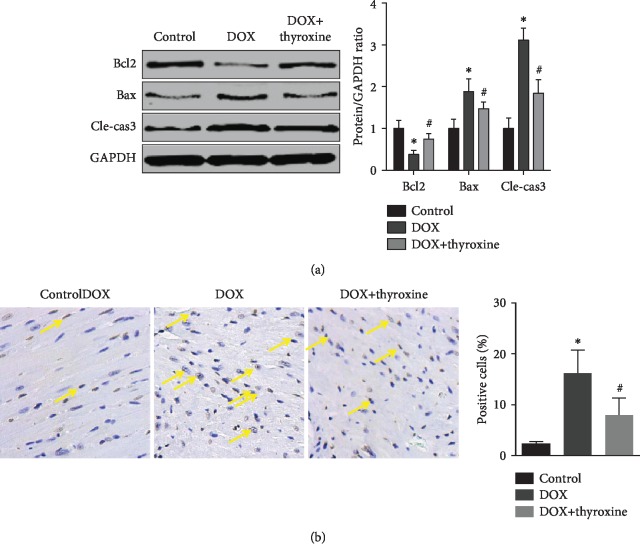
Effects of thyroxine on myocardial cell apoptosis. (a) Representative images and quantification of Bcl2, Bax, cleaved caspase-3 (cle-cas3), and GAPDH in the LV for each group by western blot. (b) Representative images of TUNEL staining and the quantitative results for each group (200x); arrows indicate TUNEL-positive cells. N = 6 in each group. ∗P < 0.05 vs. control group; #P < 0.01 vs. DOX group.